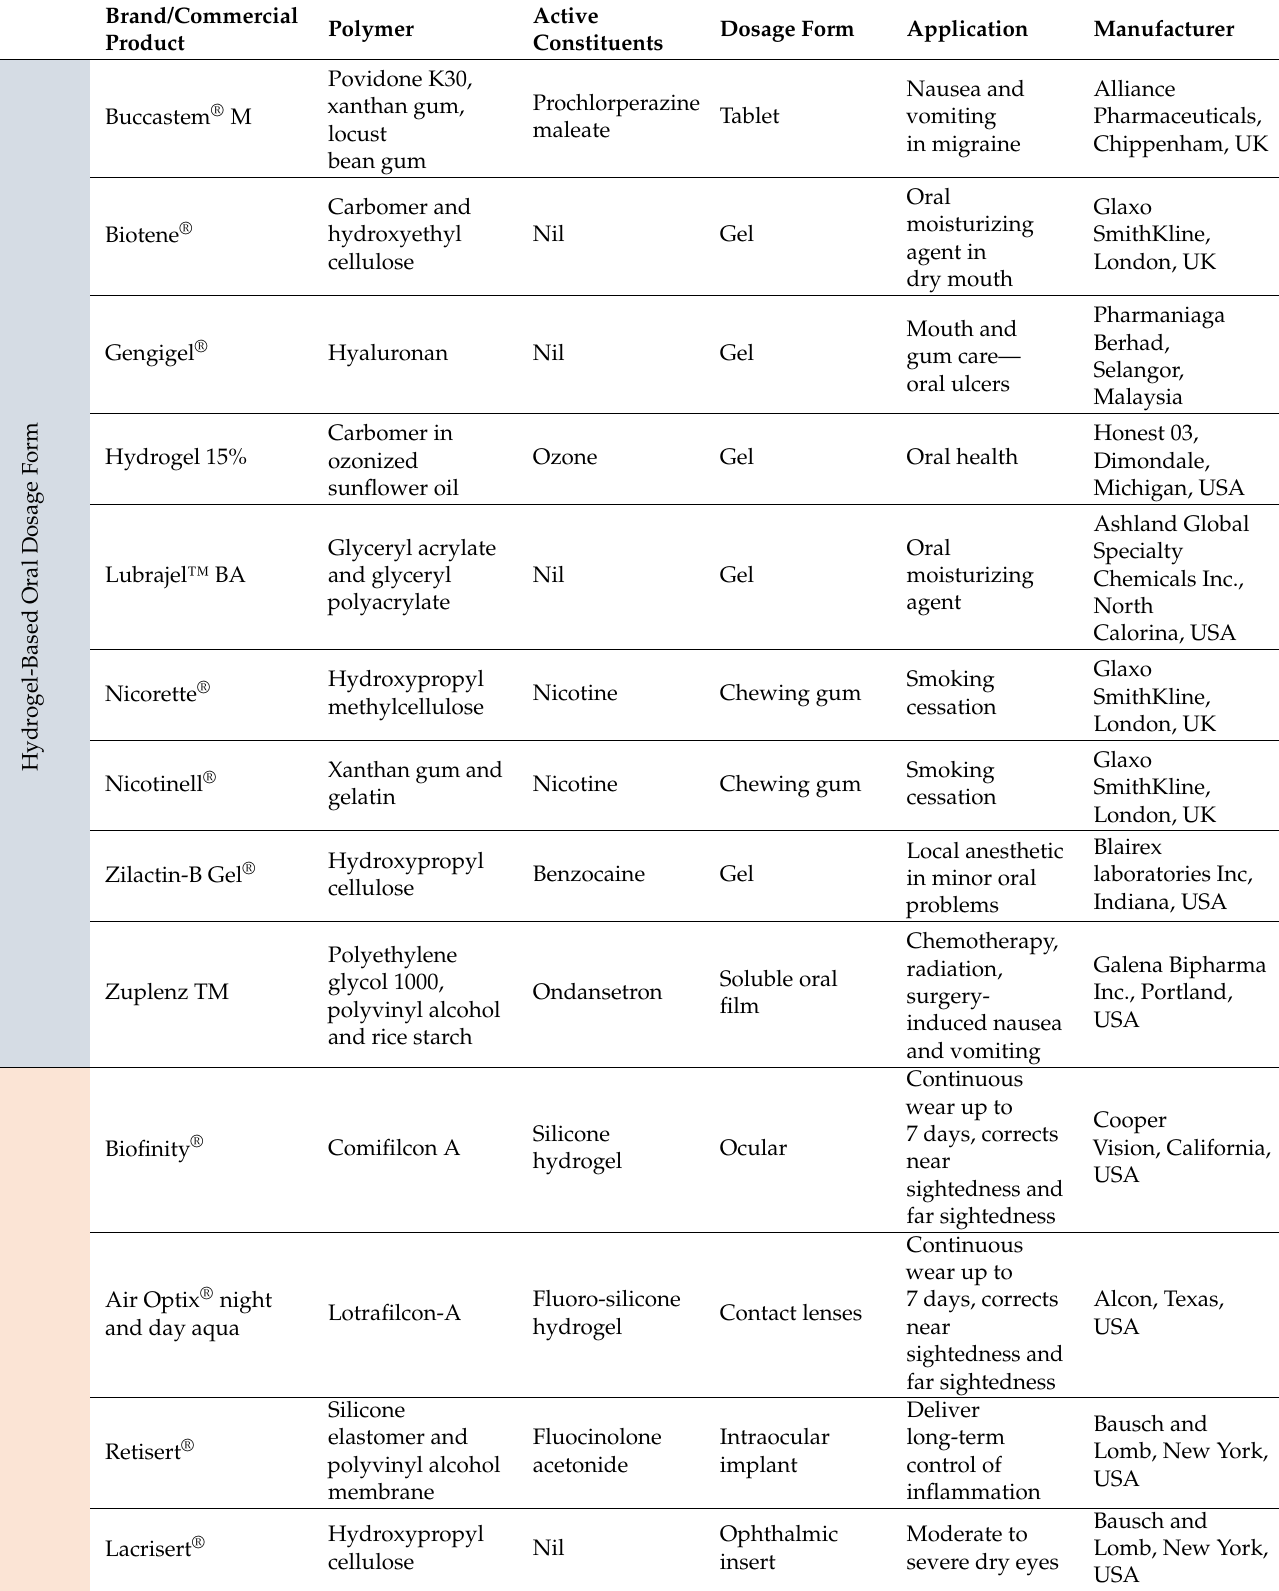
Table 2. Hydrogel-based commercially available dosage forms and their